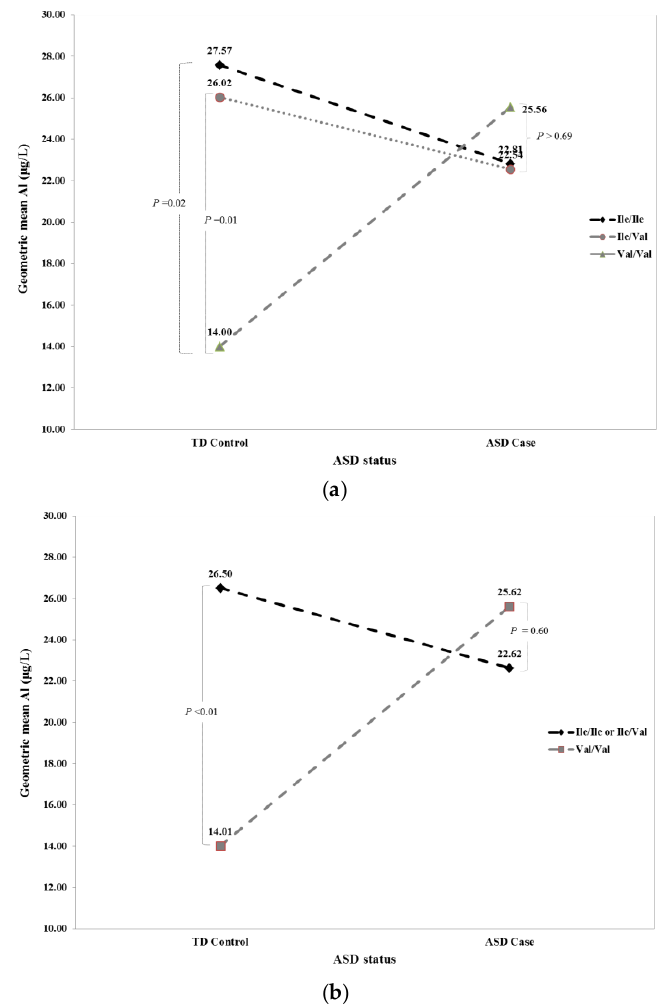
Figure 1. ( a ) Unadjusted geometric blood aluminum concentrations based on result from Full Model in Table 4; and ( b ) unadjusted geometric blood aluminum concentrations based on result from Recessive Model in Table 4.